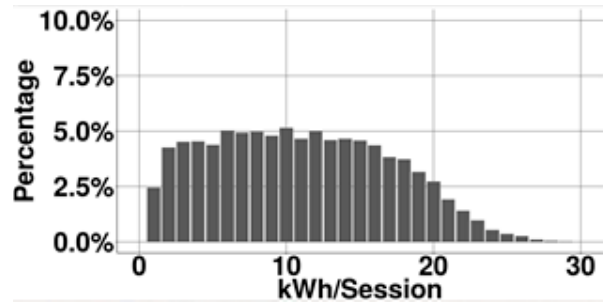
Figure 4. Distribution of charging volume at fast charging stations.